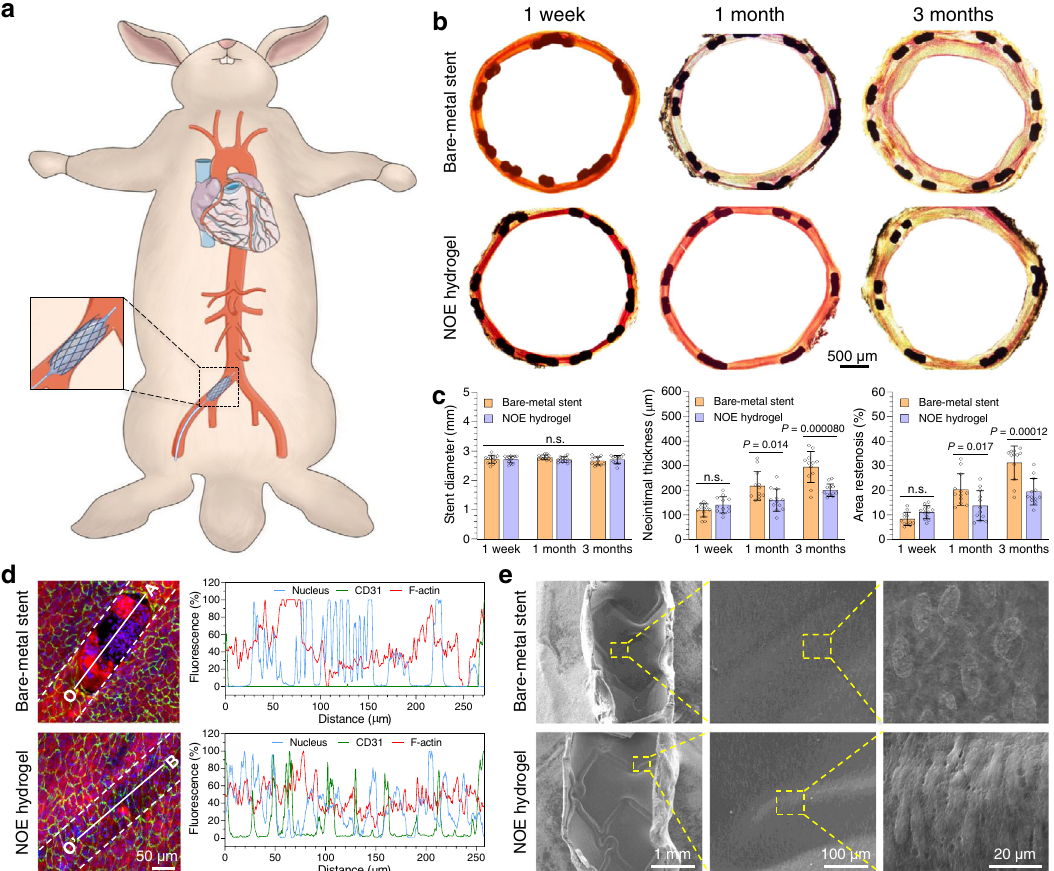
Fig. 6 Vascular stent deployment in rabbits. a Schematic illustration for vascular stent deployment in rabbit iliac arteries. b Optical images showing the cross sections of the stented arteries after van Gieson staining. c Quantitative analyses on the cross sections (mean ± SD, n = 12 independent animals). d Confocal laser-scanning microscopy (CLSM) unveiling the endothelialization on the stents (outlined by the dashed lines). The fl uorescence intensities of different cell components along the line segments (OA, O ’ B) in the images were presented (blue: cell nucleus, green: CD31, red: F-actin). Six independent pairs of samples were observed with similar results. e Scanning electron microscopy (SEM) images showing the luminal faces of the stented arteries at 3 months post stent deployment. Three independent pairs of samples were observed with similar results. One-way ANOVA with Tukey post hoc test was performed to determine the difference among various groups and two-tailed Student ’ s t -test was assumed to determine the difference between two groups. ( n.s. not signi fi arteries of rabbits (Fig. 6a and Supplementary Fig. 20). BMSs of